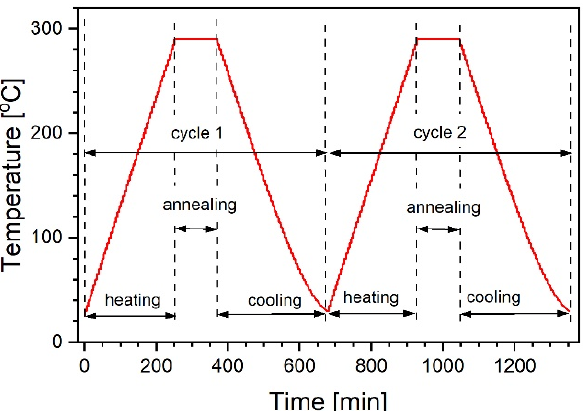
Figure 1. Scheme of the applied heating/cooling protocol. The red line represents temperature variations. The protocol consisted of two identical cycles. At the beginning of the cycle, the temperature was raised in increments of 5 °C and stabilized for 5 min. After reaching 290 °C, annealing continued for 2 h. The cycle ended with cooling, performed in a manner exactly opposite to the heating course. The cycle started and ended at 30 °C. These successive protocol steps are referred to in the subsequent text as first heating, first annealing, first cooling, and the same for the cycle 2.